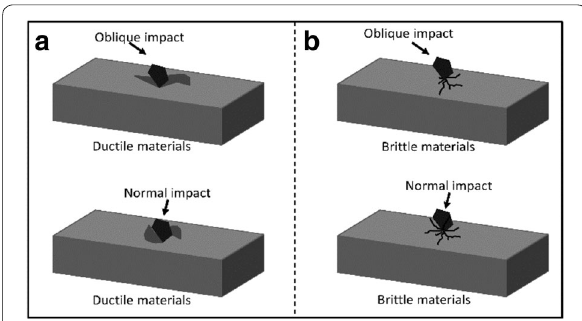
Figure 2 Schematic diagrams of the solid particle erosion process of ductile and brittle materials: ( a ) Ductile materials; ( b ) Brittle